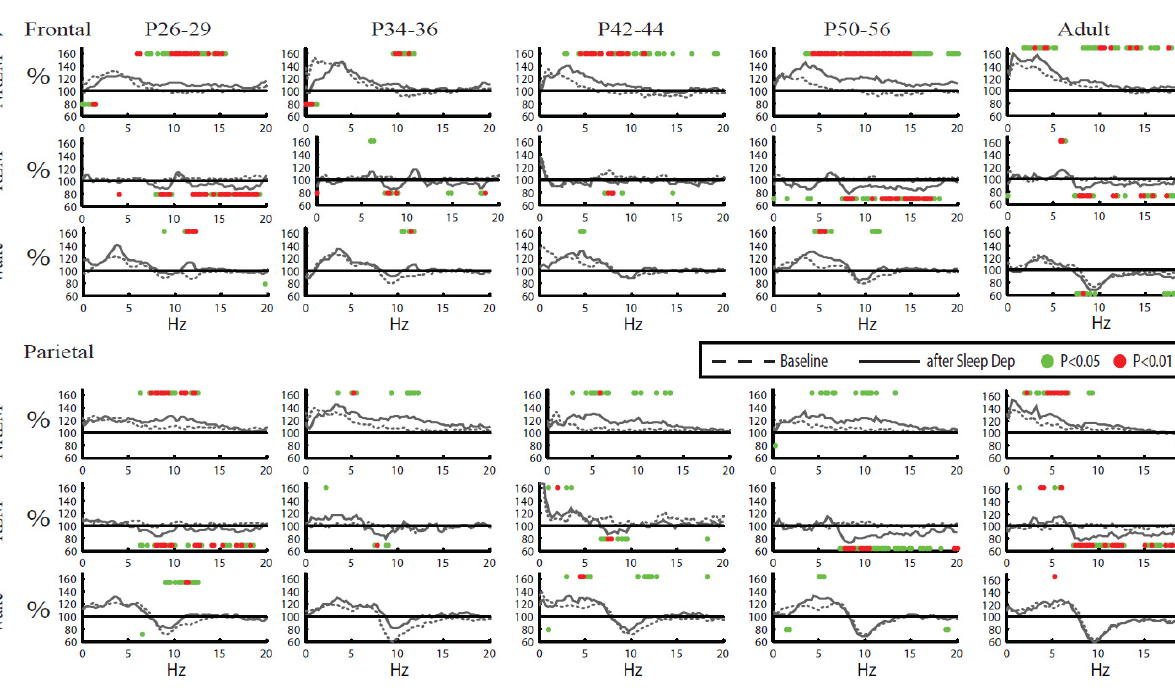
Figure 8. Overall changes in EEG power spectra after sleep deprivation for all vigilance states. Mean EEG spectra for NREM sleep, REM sleep and wake during baseline (dotted line) and sleep deprivation (solid line) are plotted in 0.25 Hz frequency bins. The mean of each frequency bin is expressed relative to its 24-h baseline mean. Spectra for NREM sleep refer to the first hour from sleep onset, when most SWA rebound occurs. Since little REM sleep occurs during the first hour of recovery, spectra for REM sleep and wake are instead mean of the first 4 h from sleep onset. Dots above and below traces indicate significant increases and decreases, respectively, after sleep deprivation vs. baseline ( p < 0.05 red, p < 0.01 green; one sample, 2-tailed t